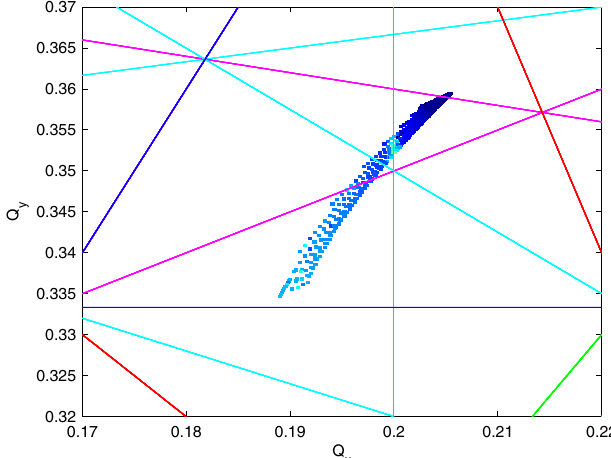
FIG. 2. Measured frequency map for the Diamond storage ring. The grey crosses identify betatron tune points correspond- ing to stable motion. The grey circles correspond to betatron tune points with losses larger than 0.1% of the beam after the kick. The colors identify the order of different resonances in the betatron tune space.